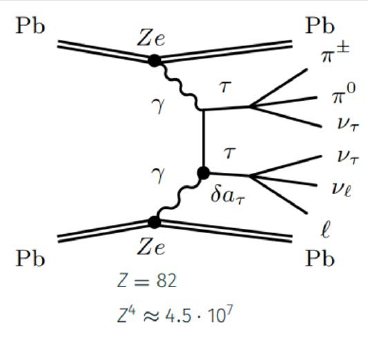
Figure 2. Diagram of pair-production of tau leptons from ultraperipheral Pb-ion collisions. One τ decays into µ + neu- trinos, the other τ decays into 3 pions + neutrino. New physics modifies the mag- netic moment by δ a τ